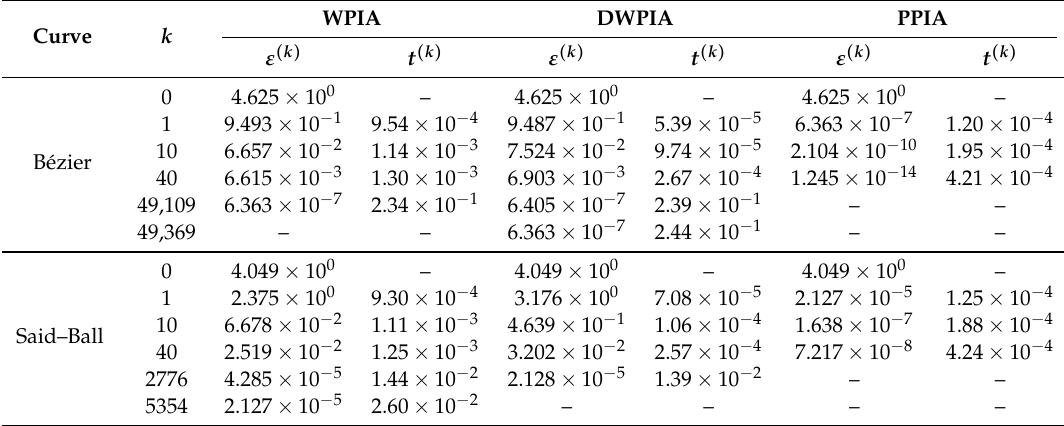
Table 4. The approximation errors and runtime of WPIA, DWPIA and PPIA in Example 3. Curve